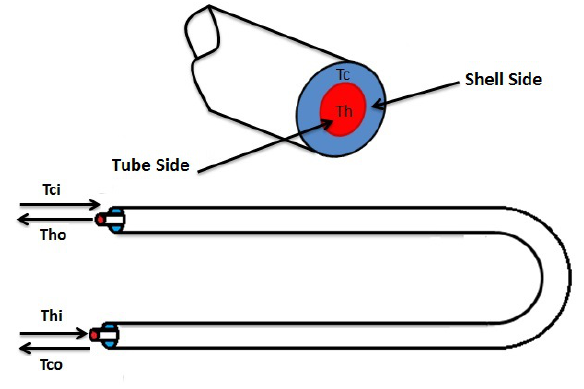
Figure 1. Countercurrent double-pipe heat exchanger.